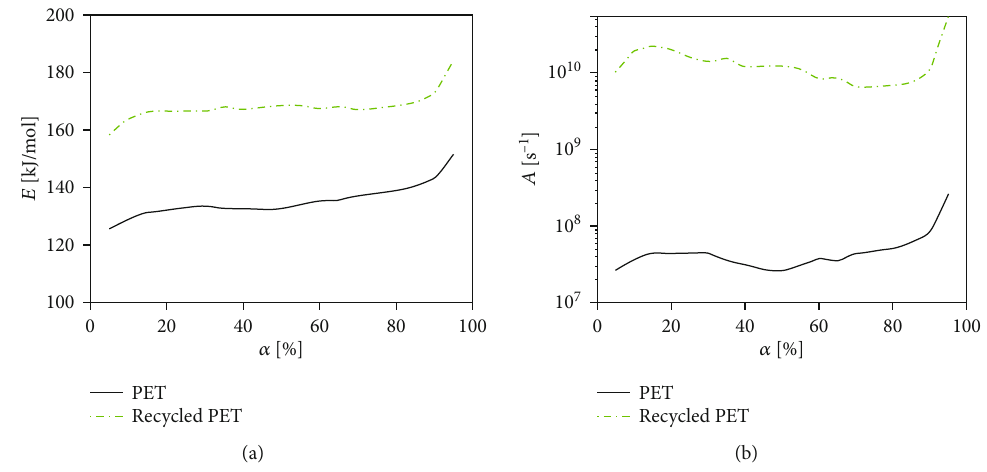
Figure 4: Kinetic parameters: (a) activation energy and (b) frequency factor.